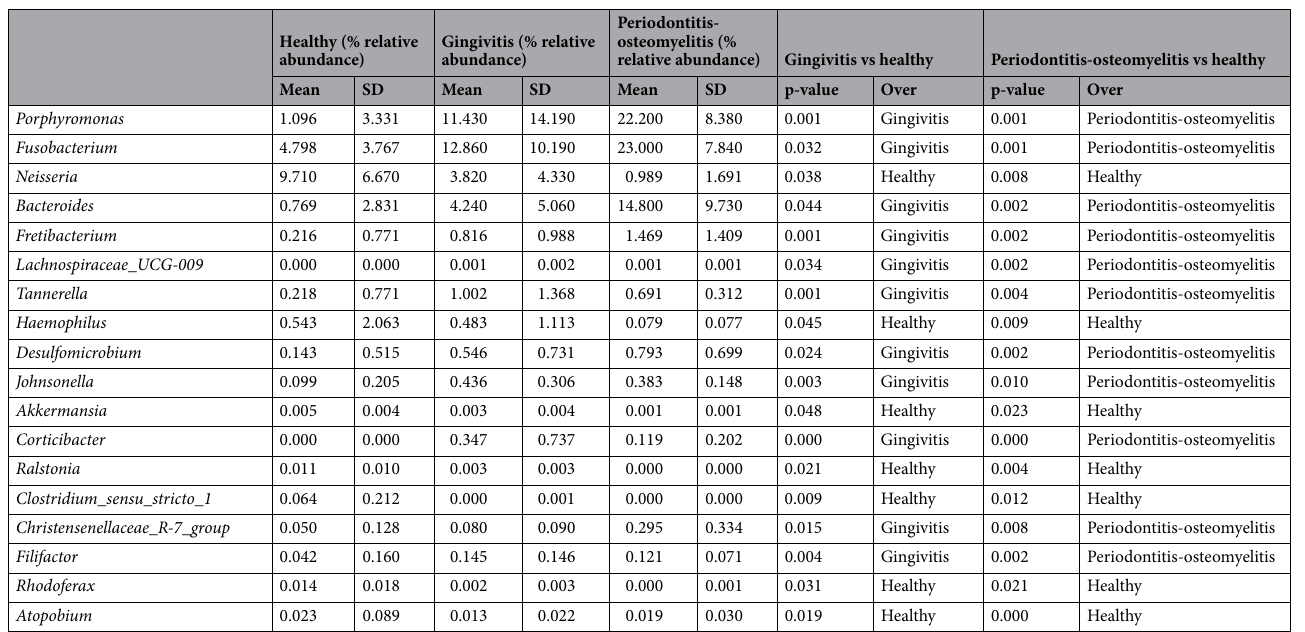
Table 1. Mean and standard deviations of genera with significant changes in gingivitis vs healthy as well as periodontitis-osteomyelitis vs healthy. LEfSe test with alpha value = 0.05 and threshold of absolute logarithmic LDA score > 2 was employed for statistical